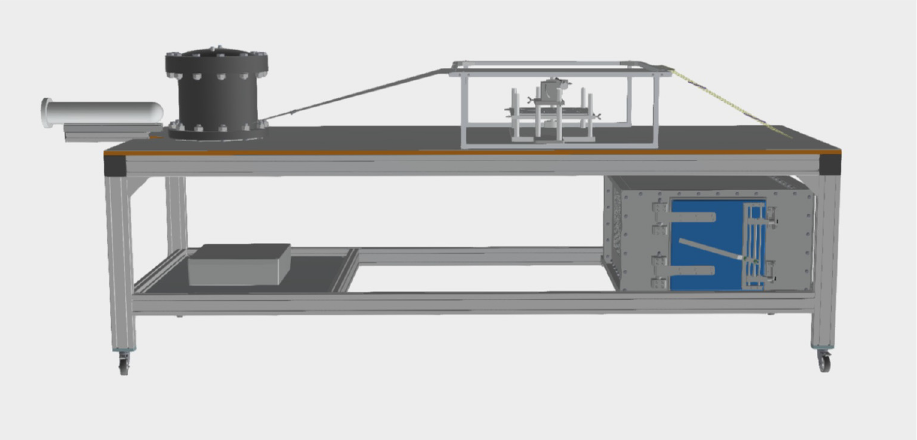
Figure 7. The complete test bed. From left to the right: Marx generator, shaping capacitor, strip line with the working section in the center and terminating resistors on the right-hand side. The screened chamber with the reference cell sample is placed under the stripline below the resistors.